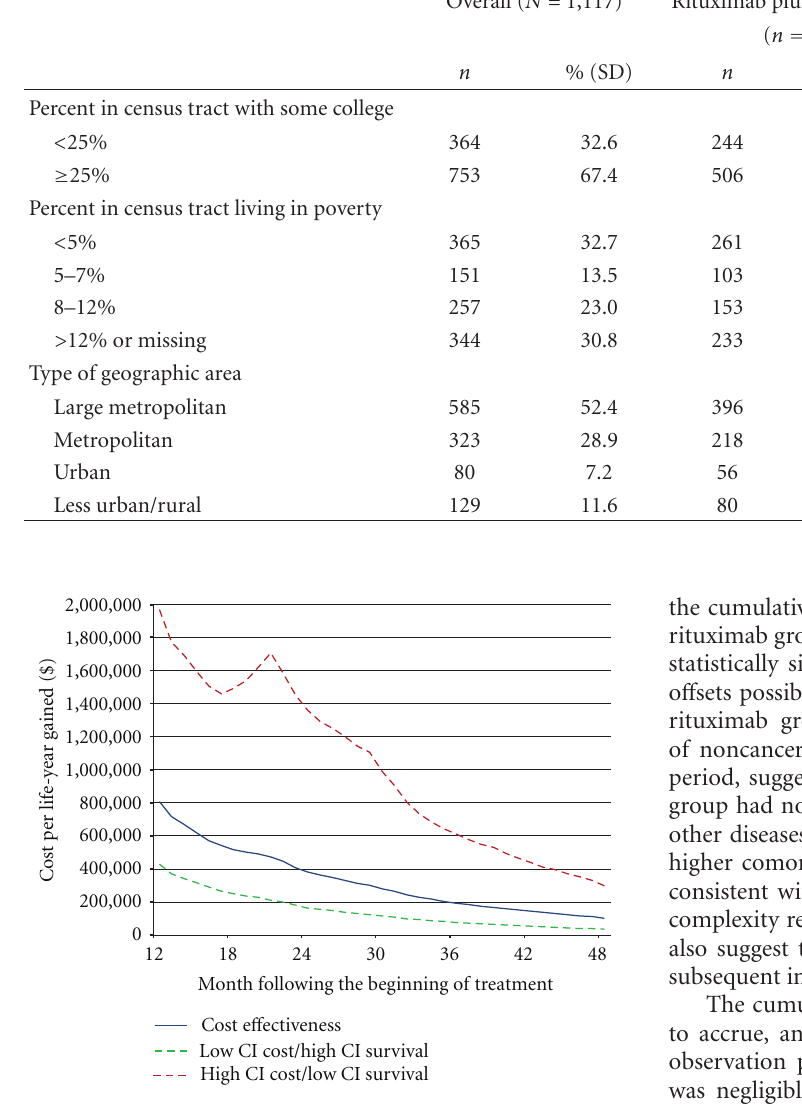
Figure 4: Cost per life-year gained associated with adding ritux- imab to